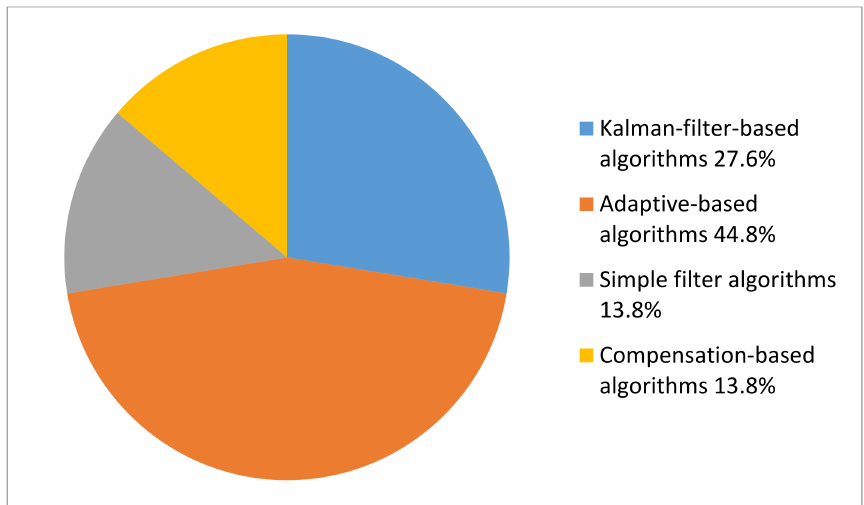
Figure 2. Proportions of the four types of algorithms in the reviewed results. (Kalman-filter-based algorithms 27.6%; Adaptive-based algorithms 44.8%; Simple filter algorithms 13.8%; Compensation-based algorithms